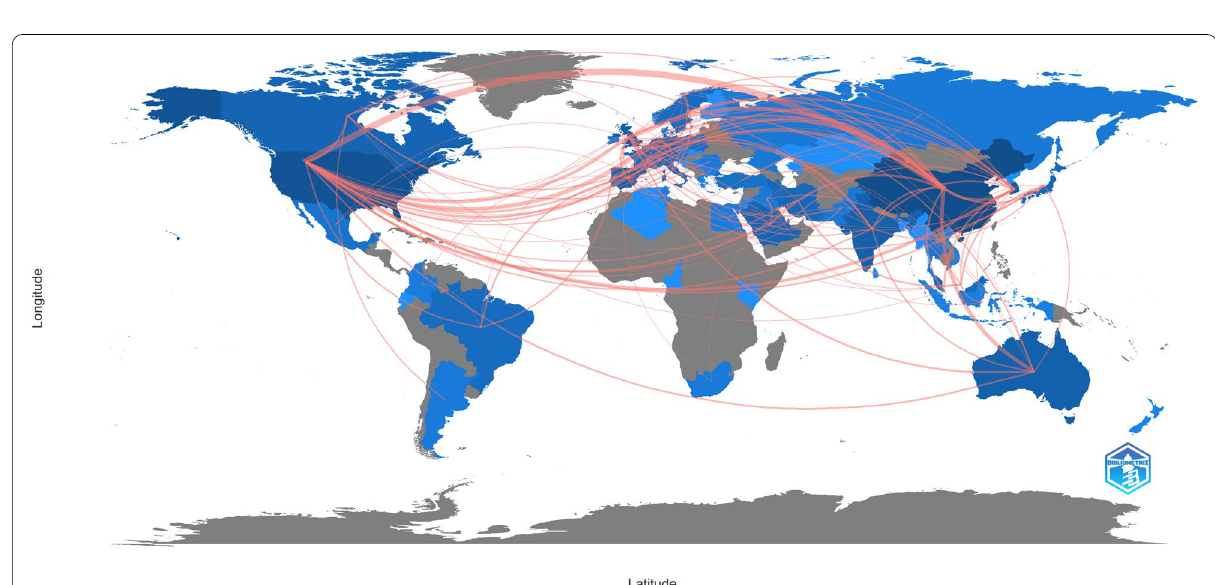
Fig. 34 Adsorbent, country collaboration